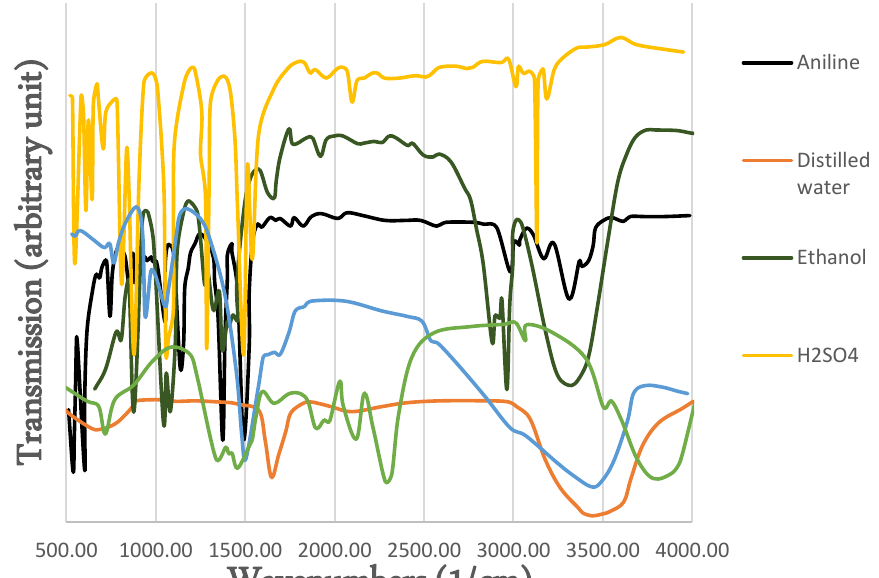
Figure 1ː FTIR spectra of pure